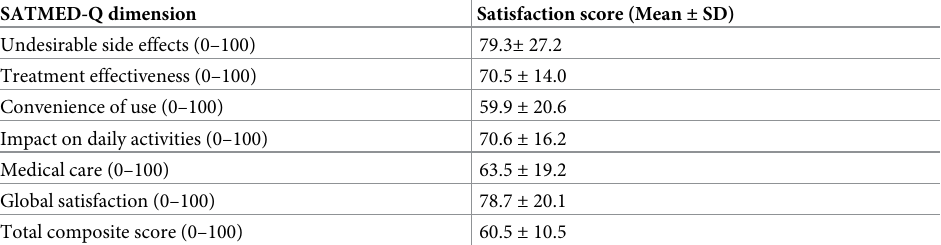
Table 8. The treatment satisfaction of heart failure patients attending cardiac clinic of Tikur Anbessa Specialized Hospital, Addis Ababa, Ethiopia June—August,